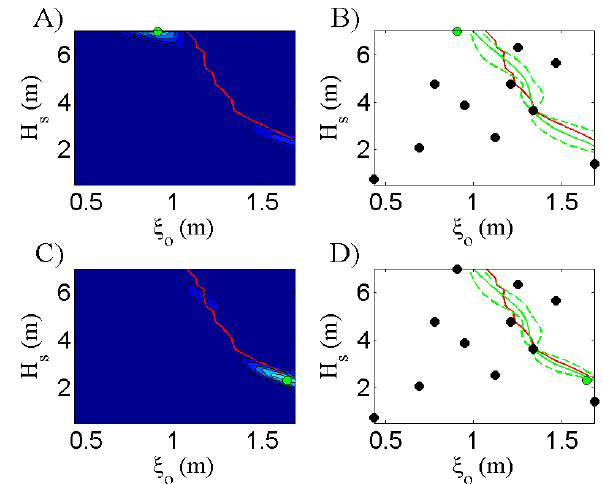
Figure 5. A) Expected improvement function values (scaled between 0 and 1) for the first iteration. The best candidate to be selected for simulation is depicted by a green dot. The reference contour is represented by a red solid line; B) The critical frontier c estimated using a kriging model constructed with the initial 10 training data and the selected training data. The associated pair of contours at confidence level 95% (defined as the kriging mean (Eq. 2) +/- twice the square root of the variance (Eq. 3)) is represented by dashed green lines. C) Expected improvement function values for the second sampling iteration; D) The critical frontier c estimated using a kriging model constructed with the initial 10 training data and the selected training data for the two first sampling iterations.